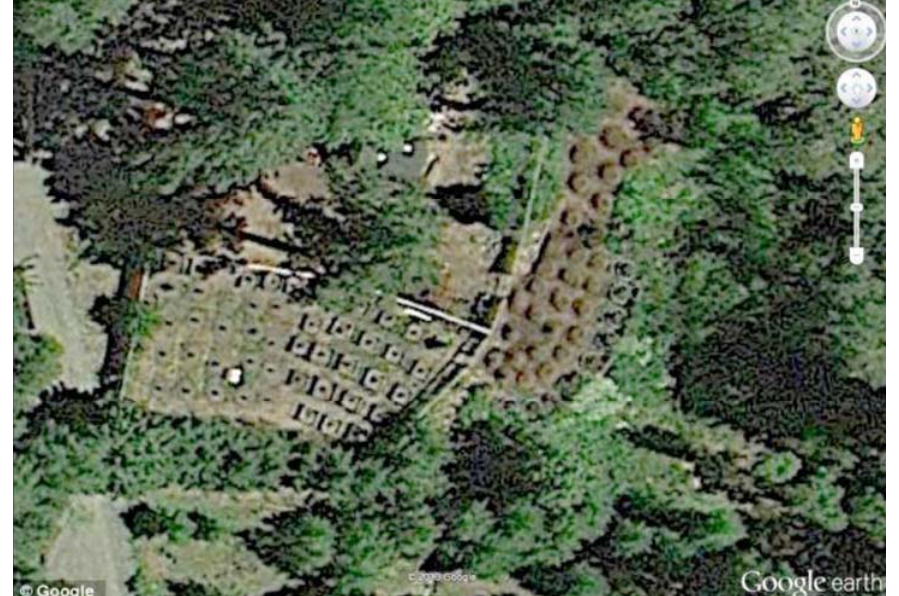
Figure 5. Image of illegal marijuana garden in Oregon, USA, located by local police via a Google Earth image from InfoWorld.com